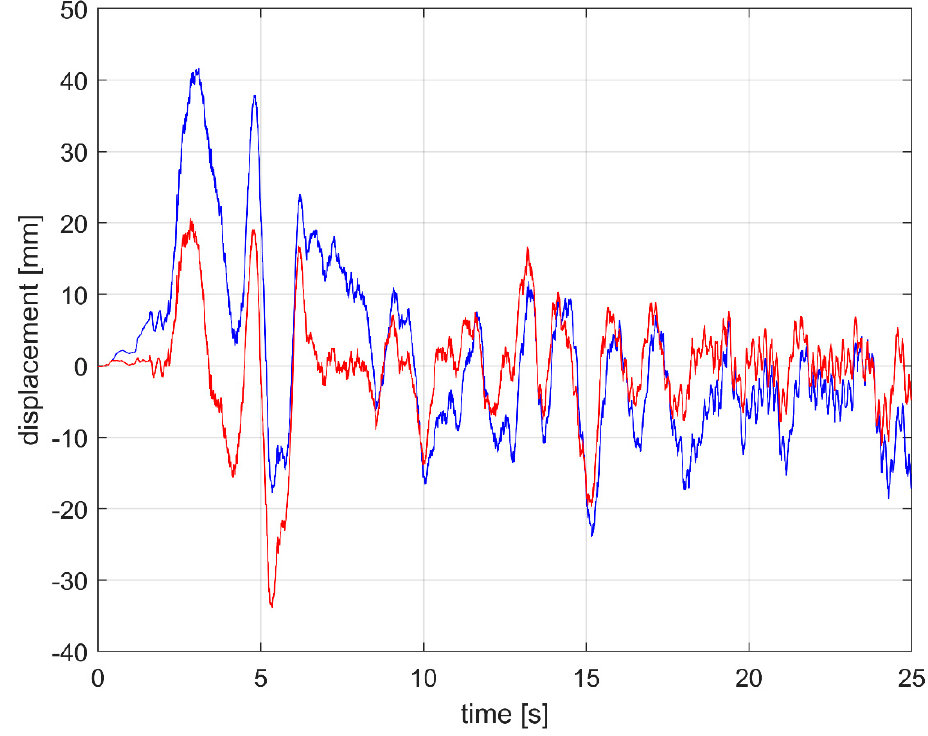
Figure 5. Displacement simulation of the sensor plate stabilized by a PID controller (red); acquired vehicle frame vibration used as input of the PID controller (blue).